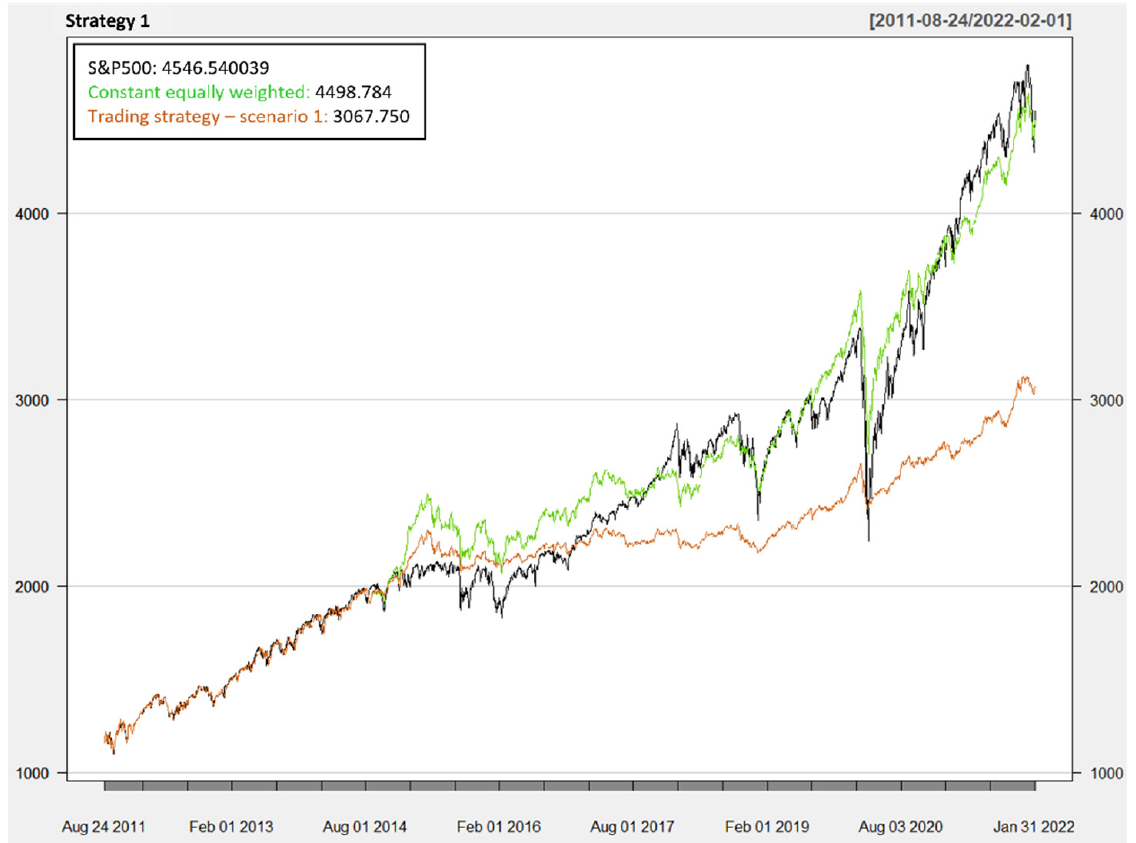
Figure 3. The development of the wealth process of the S&P500 (black), Strategy 1 (orange) and a constant equally weighted portfolio (green) .